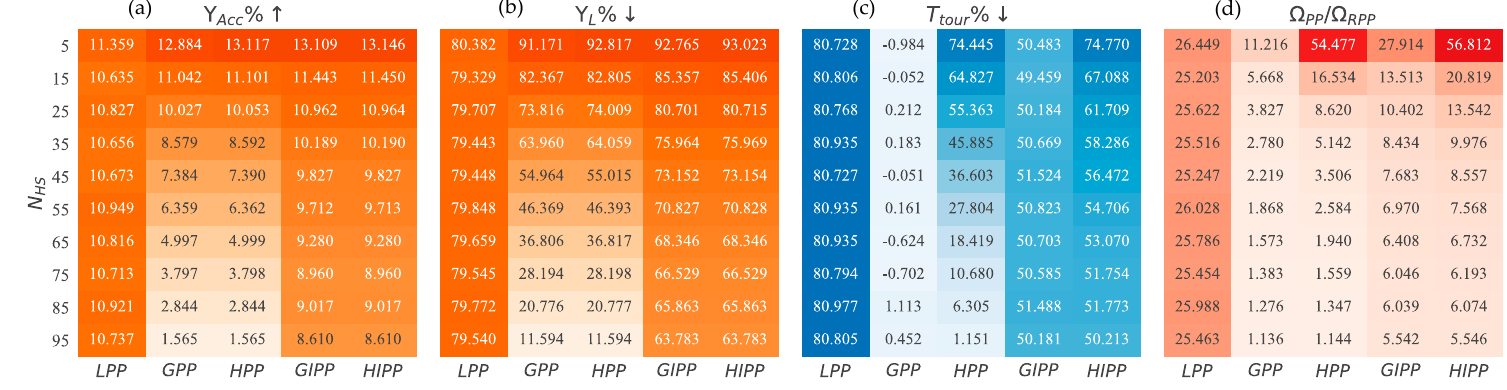
Figure 7. Scaling of response w.r.t. number of hot-spots N HS : ( a ) Percentage improvement in VoI accumulated Υ ACC ; ( b ) Percentage reduction in VoI lost Υ L ; ( c ) Percentage reduction in tour time T Tour ; ( d ) Normalized measure of efficiency Ω .